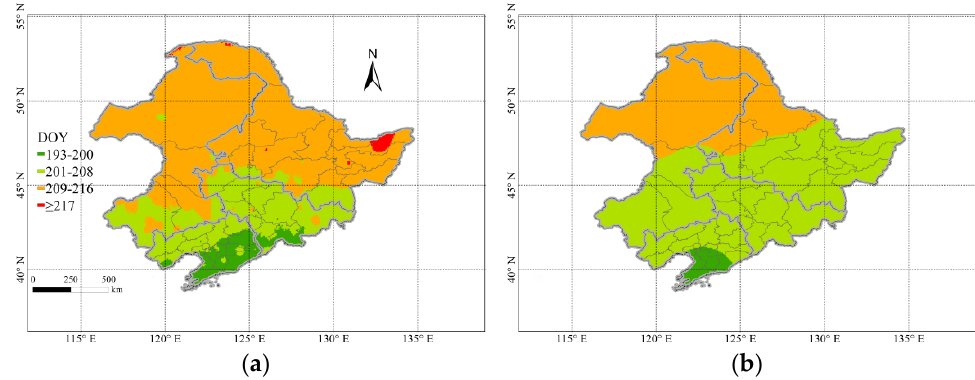
Figure 10. Maize silking stage (R1) in Northeast China (( a ) fusion data; ( b ) original data).